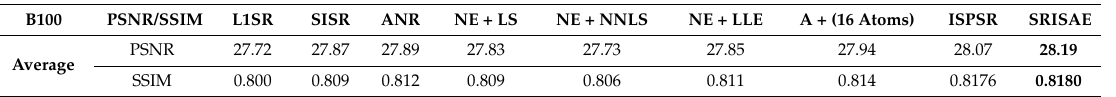
Table 5. Comparison of the average of PSNR and SSIM of the reconstructed images with different SR algorithms for B100 (PSNR/SSIM).